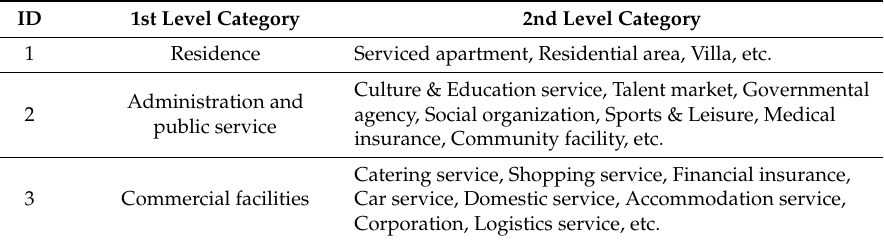
Table 2. Categories of